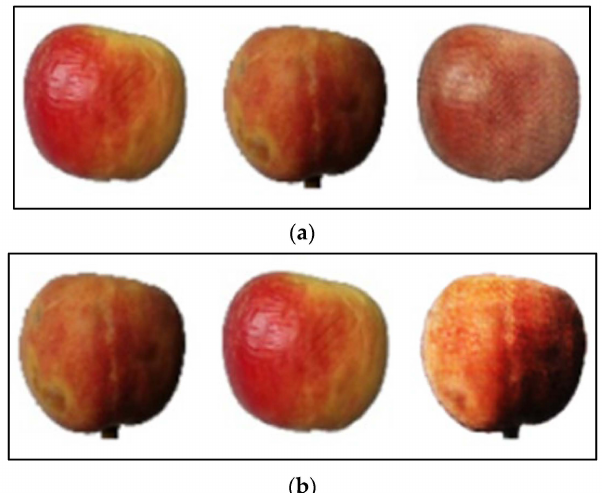
Figure 16. Error cases by the proposed PI-CNN. From the left to right: ( a ) apple, peach, and augmented apple; ( b ) peach, apple, and augmented